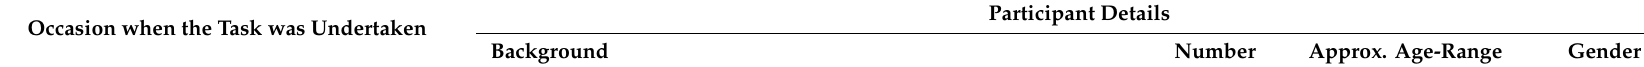
Table 2. Details of the three groups of educators undertaking the ‘evolved strategy’ sorting